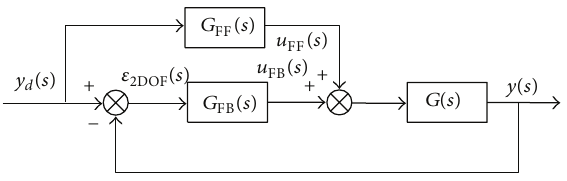
Figure 1: Block diagram of 2DOF control